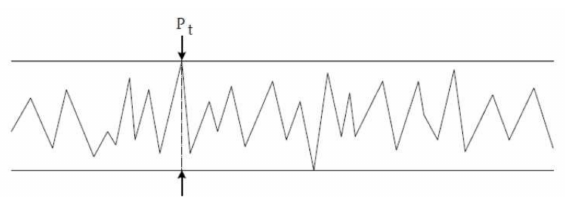
Figure 5. Profile section of profile depth Pt.